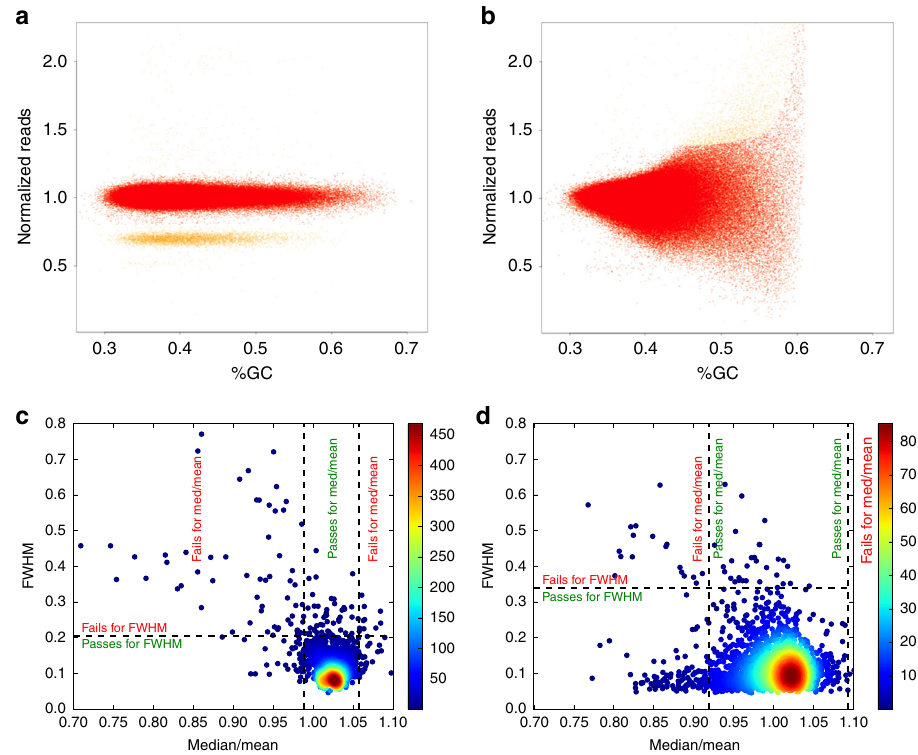
Fig. 1 Measuring evenness of coverage. FWHM looks at the GC content versus the normalized coverage for a an evenly covered sample and b an unevenly covered sample. The main copy number state of the samples, is indicated in red. The yellow cloud represents a different copy number state of a copy number aberrant region. FWHM is calculated on the main copy number state. FWHM is compared to MoM using density scatter plots showing the two measures for c normal samples ( n = 2832) and d tumour samples ( n = 2959). The number of samples overlapping is re fl ected by the colour at that point as shown by the legend. The dashed lines re fl ect the thresholds for the evenness measures. These graphs show that while there are certain samples both methods pick out as being unevenly covered, there are also samples picked out by one of the